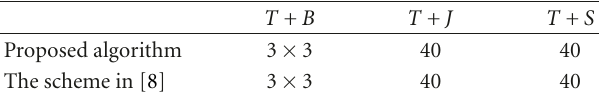
Table 7: The comparison of the performance of detecting attacked areas when combined manipulations are applied to the image I 18 in Figure 10. The symbols and the numbers have the same meanings as those in Figure